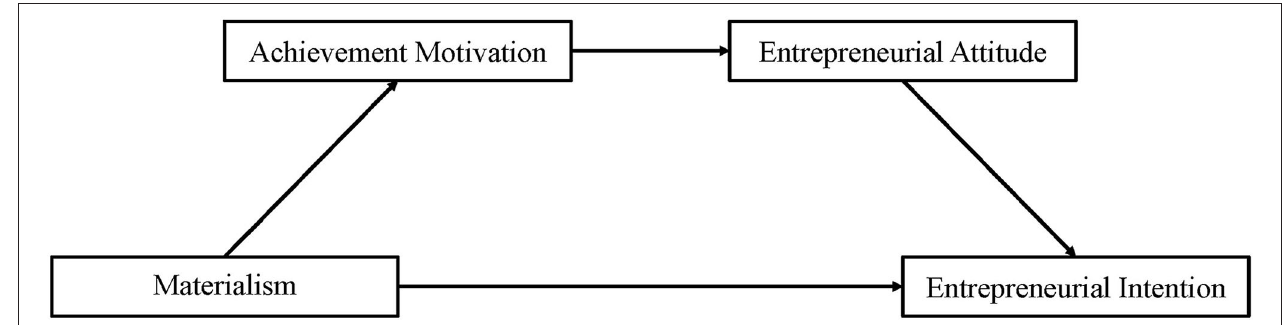
FIGURE 1 | Hypothesized model of serial-multiple mediation of achievement motivation and entrepreneurial attitude in the relationship between materialism and entrepreneurial intention.